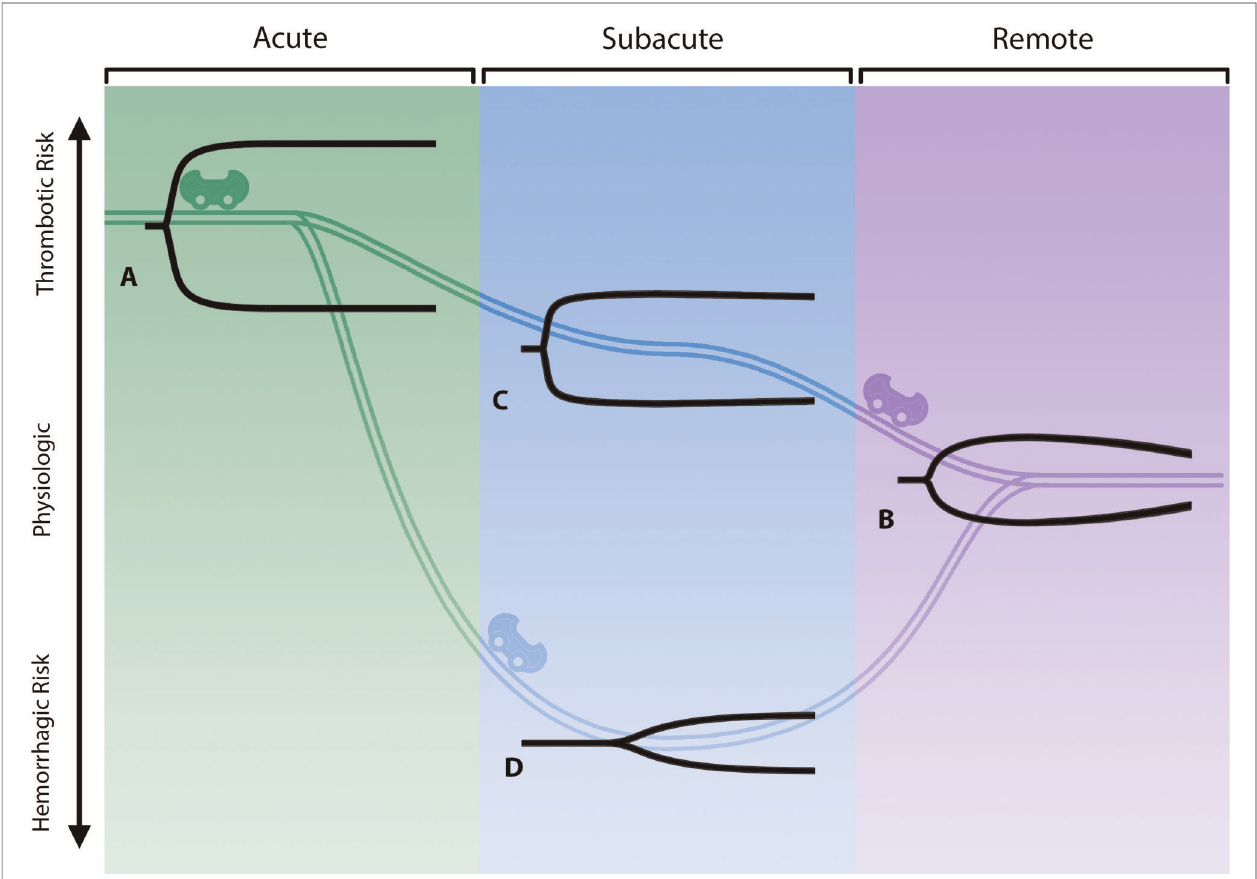
FIGURE 3 | The “ rollercoaster ” phenomenon of COVID-19-associated coagulopathy. The three stages of COVID-19-associated coagulopathy and their relationship to the immuno-thrombotic derangement caused by the cytokine storm are represented above by viscoelastic hemostatic assays (e.g., thromboelastography [TEG]). ( A ) represents the acute fi brinolytic shutdown phenotype (short R, steep α , thick MA, no lysis). ( B ) represents the eventual evolution to a normal physiologic fi brinolytic phenotype (normal R, α , MA, and LY30). ( C ) represents the TEG in evolution without anticoagulation and the subacute recovery stage where the patient is less hypercoagulable (parameters intermediate between acute and remote). ( D ) represents the patient with or without anticoagulant with a hypocoagulopathic phenotype due to hypo fi brinogenemia and/or a thrombocytopenia in spite of persistent fi brinolytic shutdown (long R, fl at α , narrow MA, no lysis) (17, 20, 77, 79 – 81). Created using Adobe